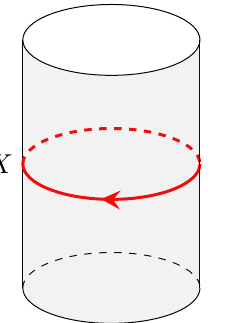
Figure 1 . On the left, an X defect line (red) is inserted along a spatial slice, this gives a “twist” by X in the time direction. On the right, the defect line is inserted along the time